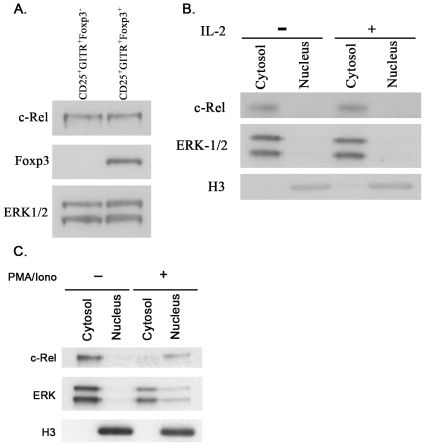
c-Rel expression in nTreg precursors.c-Rel expression in nTreg precursors and nTregs. (A) Whole cell lysates from equivalent numbers of purified nTreg precursors and nTregs were analysed by Western blotting for c-Rel, Foxp3 and ERK (loading control) expression. The data is representative of three independent experiments. Purified nTreg precursors cultured in the absence or presence of IL-2 (B) or PMA plus ionomycin (C) for 2 hrs were subjected to sub-cellular fractionation and Western blots performed on nuclear and cytosolic fractions for c-Rel, ERK (cytosolic loading control) and histone H3 (nuclear loading control) expression. The data shown in panels B and C is representative of three independent experiments.